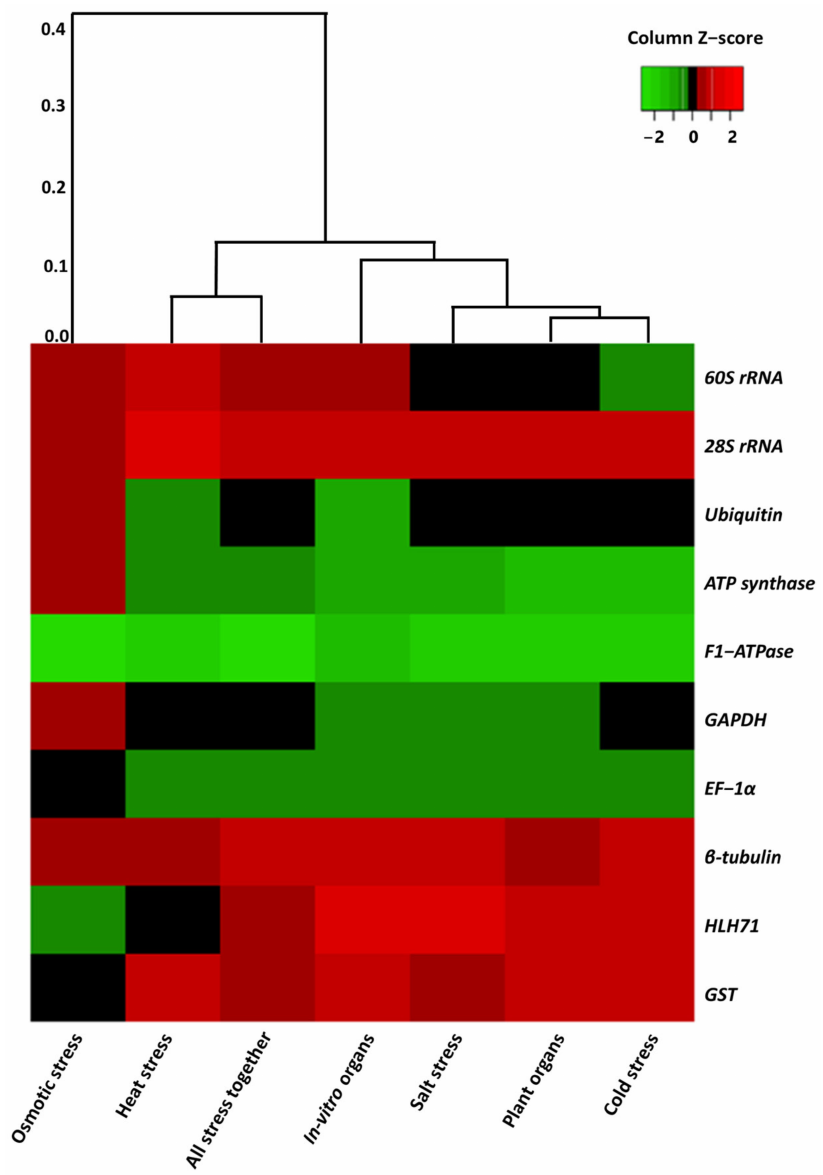
Figure 1. Heatmap of candidate reference genes based on their Ct or cycle threshold values. Expres- sion levels of the candidate genes is represented by three main colors (green, black, and red). The red color indicates a high Ct value or low expression and the green color indicate a low Ct value, which corresponds to high expression. The black color represents neither high nor low Ct values (moderate values). Table 2. Expression stability of candidate genes analyzed by ∆ Ct and